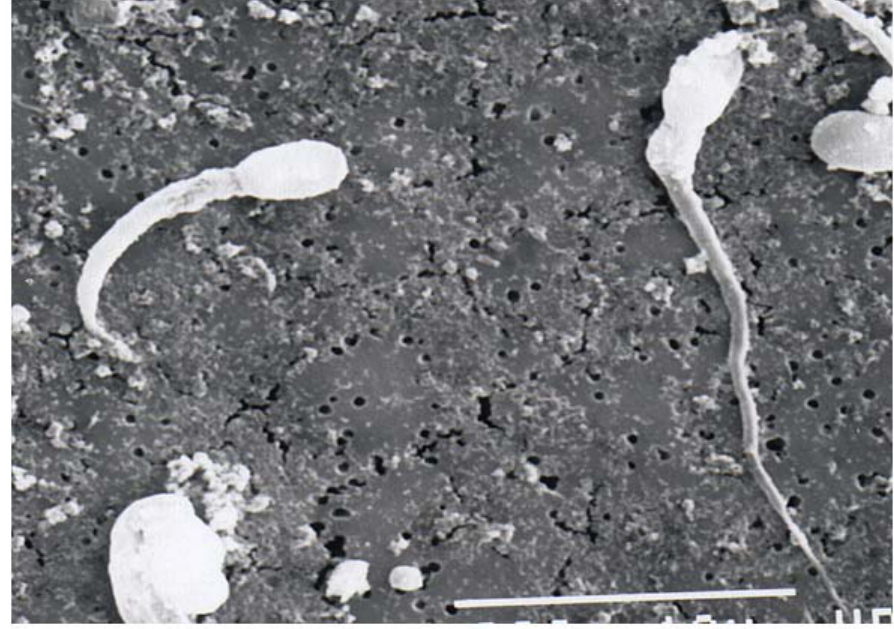
FIGURE 2. The photography shows a short-tail spermatozoa on the left, and a normal-length spermatozoa tail on the